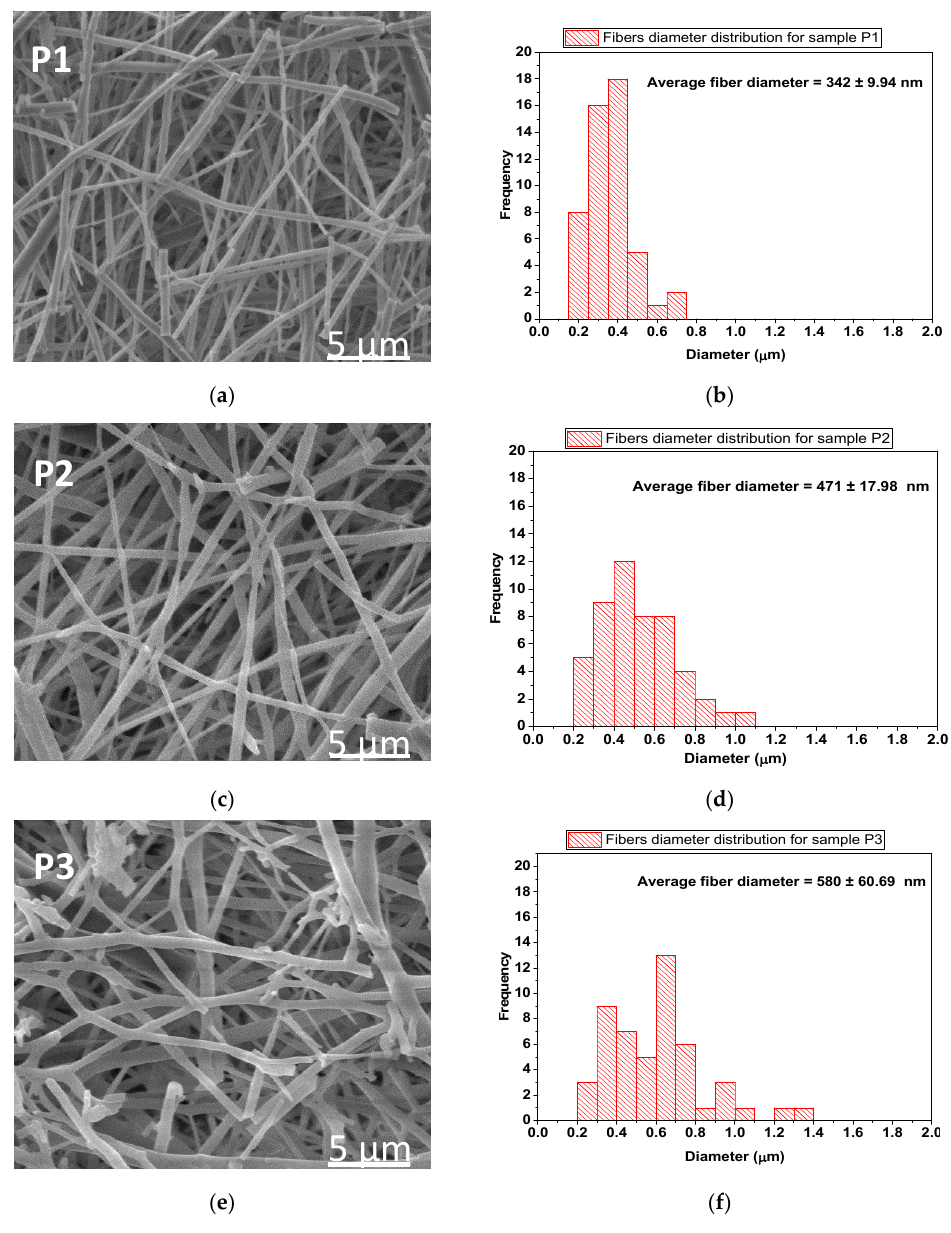
Figure 6. Scanning Electron Microscopy (SEM) images for P1 ( a ), P2 ( c ) and P3 ( e ) electrospun samples (magnification 10 kX) and fibre size distribution ( b,d,f ).